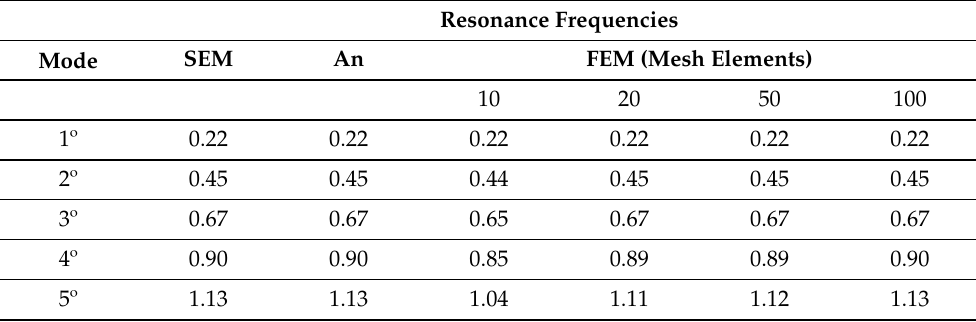
Table 5. Cable resonance frequencies obtained with the spectral element (SEM), analytical solu- tion(An), and finite element method (FEM) calculated with different mesh discretization. Resonance Frequencies SEM An FEM (Mesh Elements) Mode 10